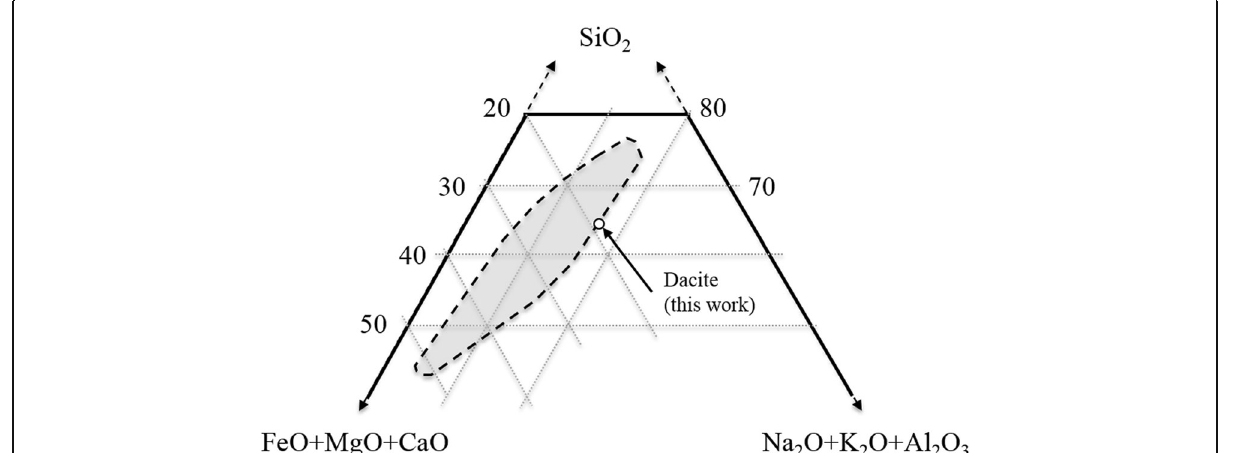
Fig. 10 Ternary diagram among SiO 2 , FeO + MgO + CaO, Na 2 O + K 2 O + Al 2 O 3 (Seddio et al. 2013). Black dotted line encloses the field of SLI (Roedder 1951). White circle plot represents the dacite clast (this